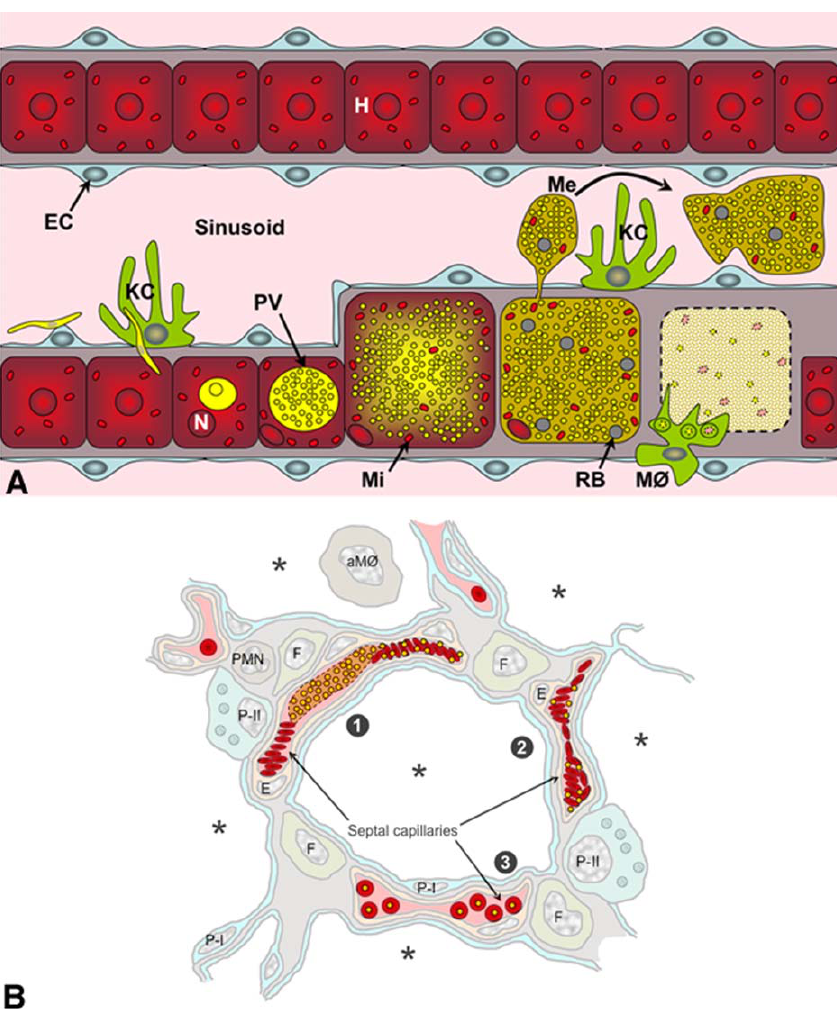
Figure 10. Model of Merosome Dissemination and Merozoite Liberation (A) After malaria sporozoite entry into a hepatocyte, the parasite begins to grow inside a PV to a size larger than its original host cell. Schizogonic division results in the formation of thousands of erythrocyte-infective merozoites. During the final stage of differentiation, the PVM dissolves and allows the parasites to mix with the remaining host cell organelles. Eventually, the plasma membrane of the infected hepatocyte bulges out and forms merosomes; thus releasing merozoites, remnant bodies, and host cell mitochondria into the sinusoidal lumen. Camouflaged by host cell membrane, merosomes are not recognized by Kupffer cells and are shuttled out of the liver. Infiltration of the remains of the infected host cell by mononuclear phagocytes and neutrophil granulocytes gives rise to the formation of a small granuloma. Me, merosomes; RB, remnant bodies; Mi, host cell mitochondria; KC, Kupffer cells; M B , mononuclear phagocytes; S, sporozoite. (B) Shear forces inside the hepatic and other larger veins cause the merosomes to break down into smaller units. After passing through the right heart, these small merosomes are arrested inside lung capillaries where (1) they eventually release infectious merozoites into the pulmonary microvasculature; (2) local stagnation of the blood flow due to capillary occlusion by merosomes may result in dense erythrocyte packing; and thus (3) facilitate merozoite infection. (cid:2) , alveolar space; H, hepatocyte; N, nucleus; E, endothelium; P-I, type I pneumocyte; P-II, type II pneumocyte; F, fibroblast; aM B , alveolar macrophage; PMN, polymorphnuclear